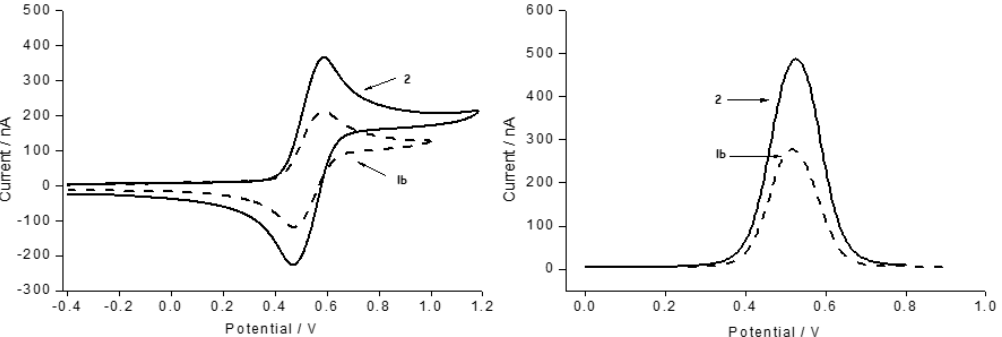
Figure 2. Cyclic voltammogram (CV) and squarewave voltammetry (SWV) response of free receptors 1b and 2 (1 × 10 − 3 mol · dm − 3 ) in CH 3 CN; supporting electrolyte: 0.1 M (n-Bu) 4 NB(C 6 F 5 ) 4 ; scan rate: 100